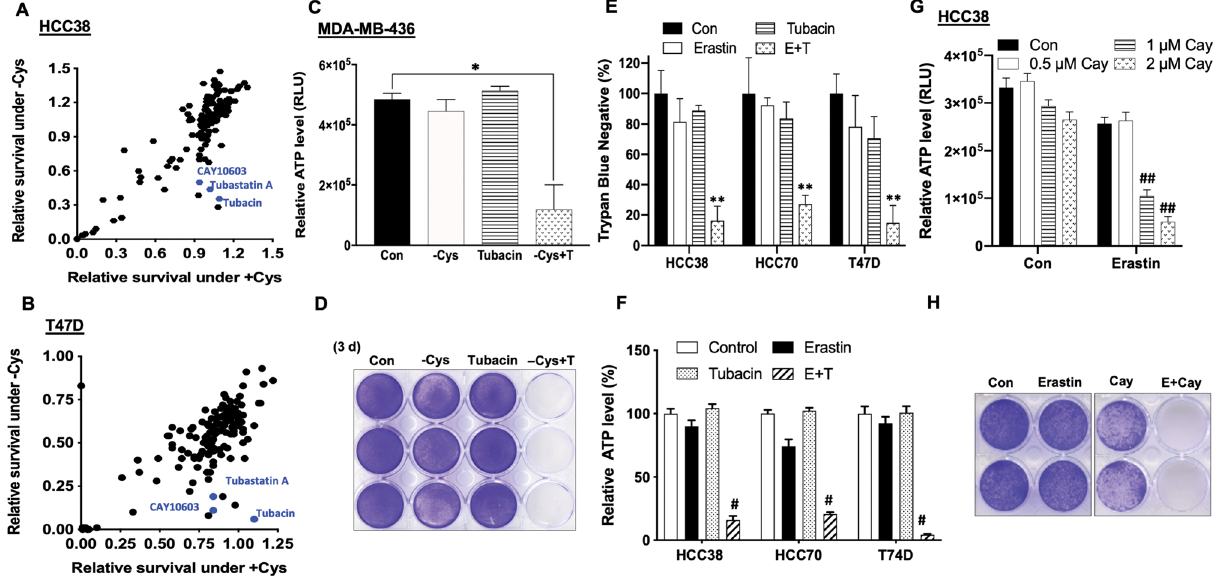
Figure 1. Epigenetic compound library screening identifies HDAC6 inhibitors to promote cell death of cystine deprivation. (A,B) Relative cell survival of TNBC HCC38 and luminal T47D cells treated with epigenetic compounds under cystine-depleted (-Cys) and cystine-replete (+ Cys) conditions were determined by CellTiter-Glo assay at 72 h. (C,D) Cell viability of TNBC MDA-MB-436 cells was measured by ATP level ( C ; n = 3; *p < 0.01) or stained by crystal violet ( D ) under either cystine-replete (Con), cystine-depleted (-Cys), 5 μM tubacin (T), or 5 μM tubacin under cystine-depleted (-Cys + T) treatments for 72 h. (E,F) Survival rate of HCC38, HCC70, and T47D cells in response to either control (Con), 5 μM erastin, 5 μM tubacin, or combination of erastin and tubacin (E + T) were determined by trypan blue counting ( E ; **p < 0.001)